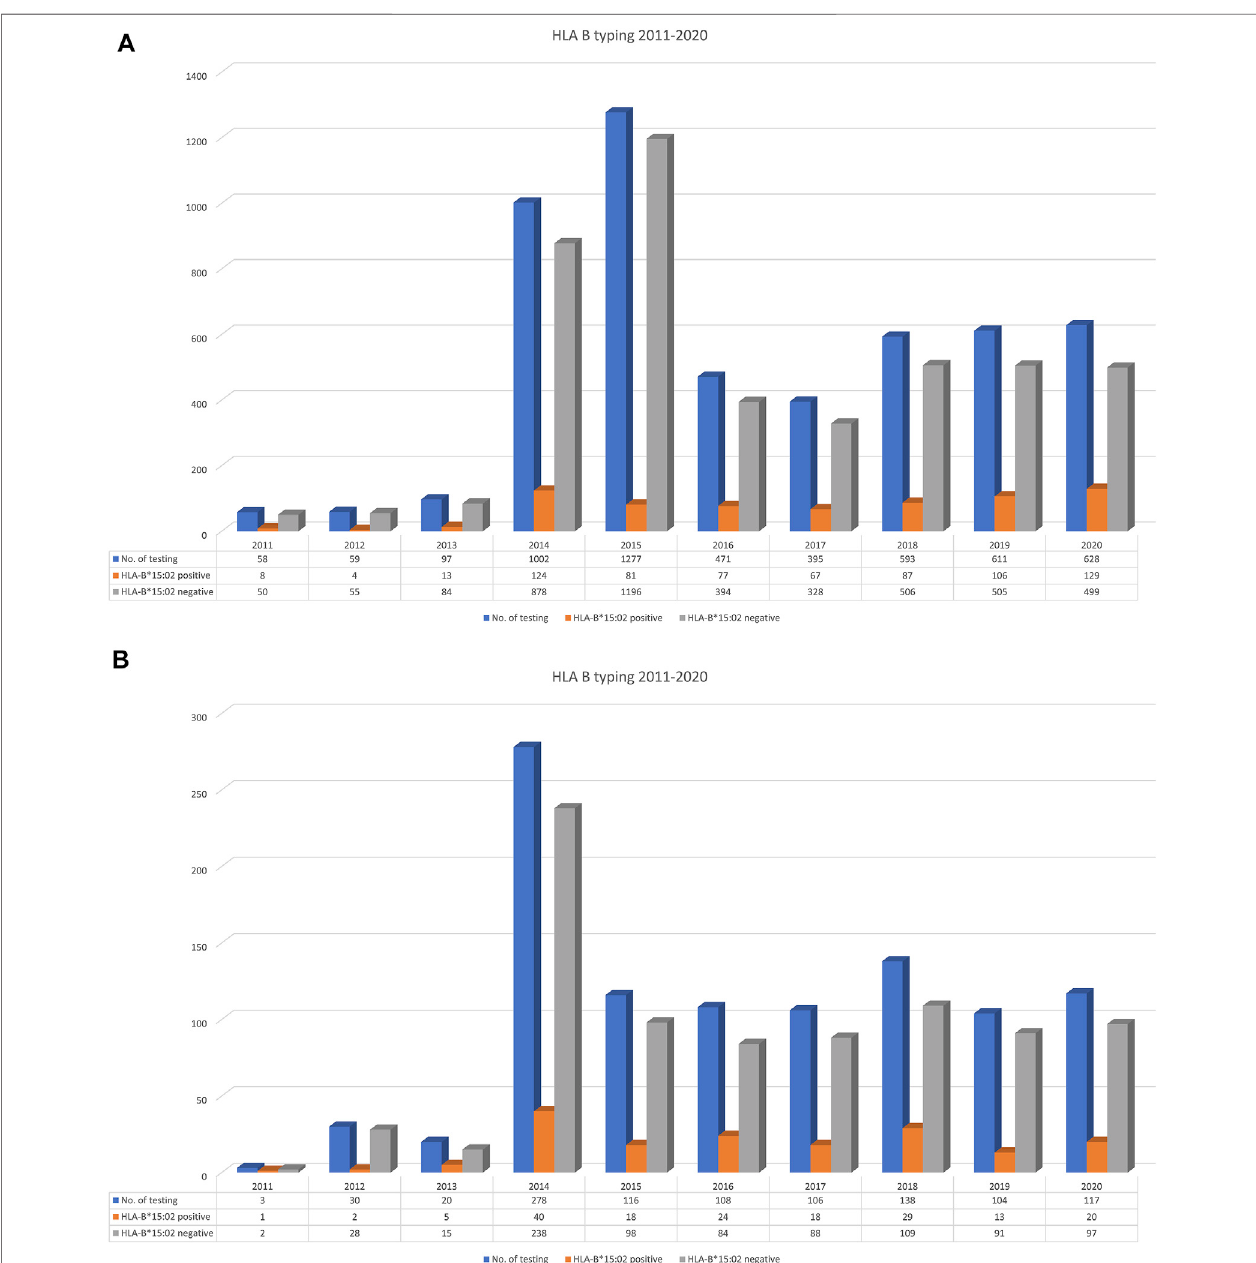
FIGURE2| Trendof HLA-B*15:02 testing requested byout-side[n=5,191; (A) ] andin-side[n=1,020; (B) ]ofRamathibodiHospital(19.64%) during 2011 – 2020.